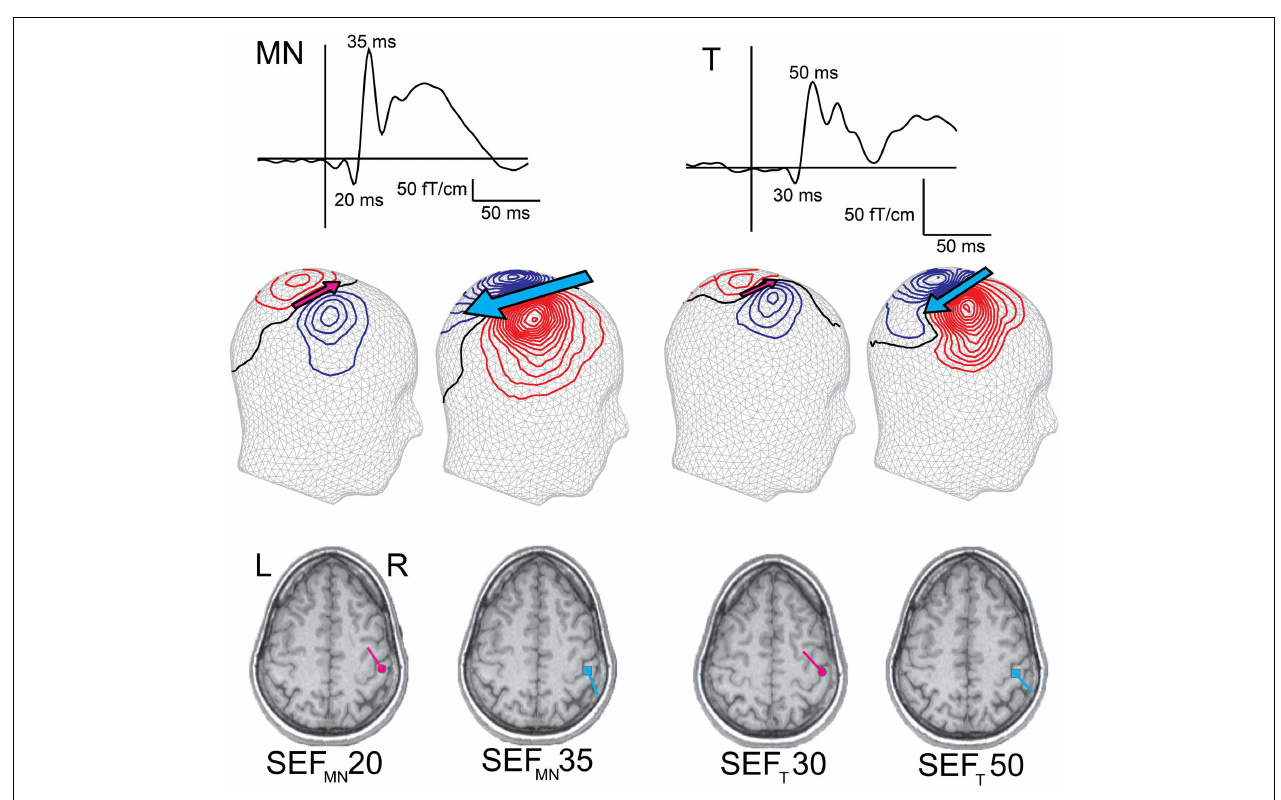
(note the different amplitude scales). Both stimulation methods, however, elicit an initial anteriorly pointing dipolar source, SEF MN 20/SEF T 30 (though in some subjects this deflection is minute to tactile stimulation), followed by a posteriorly pointing dipolar source, SEF MN 35/SEF T 50.The dipoles are superimposed on individual MRIs and both sources are localized in